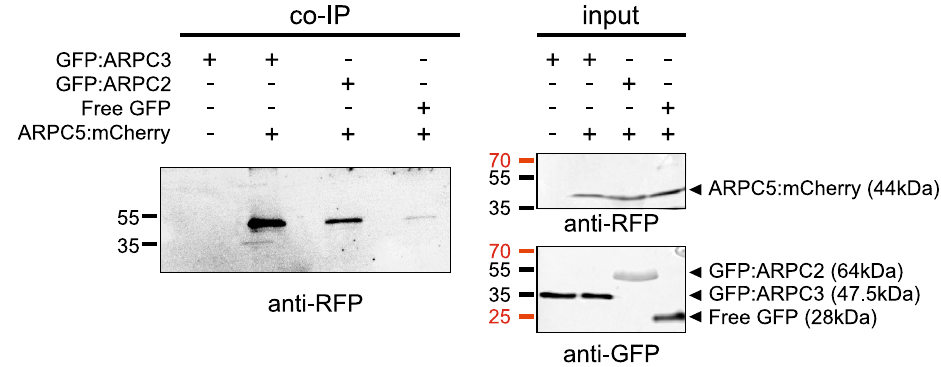
Figure 6. ARPC3 and ARPC5 interact in vivo . Co-immunoprecipitation assays prove the interactions between ARPC3 and ARPC5 using the magnetic bead GFP isolation method. Either GFP-tagged ARPC3, GFP-tagged ARPC2A (positive control), or free GFP (negative control) were co-expressed with mCherry-tagged ARPC5. Protein interactions in the immunoprecipitated samples (left panel, co-IP) were detected by immunostaining with anti-RFP antibody. Protein extracts (right panel, input) were immunostained with anti-RFP and anti-GFP. Blots were cropped; original uncropped blots are presented in Fig.